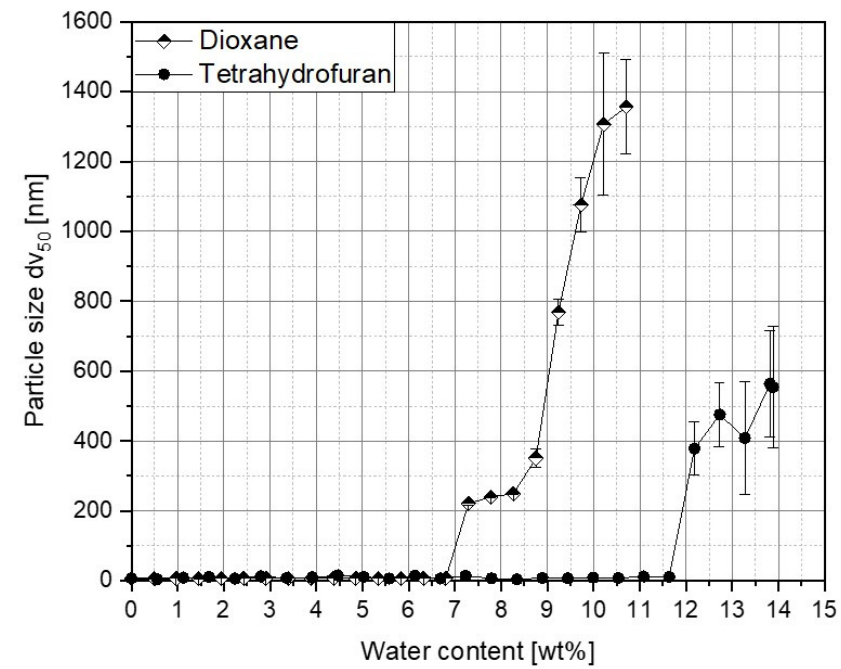
Figure 4. Determination of critical water contents using dynamic light scattering. Block copolymer solutions of 0.1 wt% with THF and dioxane were investigated.